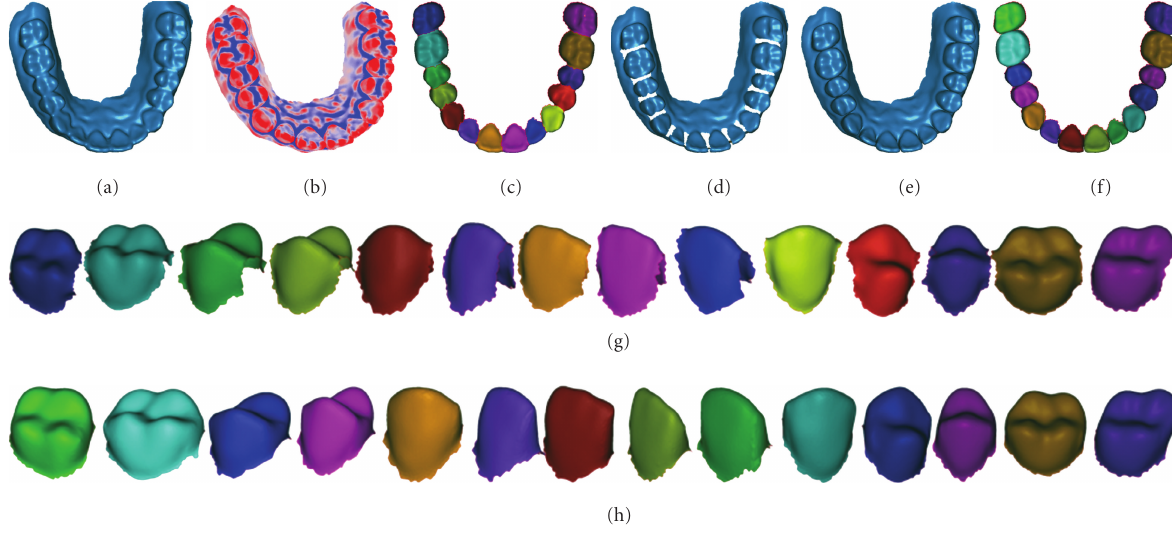
Figure 16: Single-tooth modeling results of 3D dental model with normal tooth arrangement. (a) The initial 3D dental model. (b) Minimum curvature color map. (c) Separation results shown as a whole corresponding to the initial 3D dental model. (d) After the fusion regions being deleted. (e) After single-tooth shape being restored. (f) Separation results corresponding to the 3D dental model after shape restoration. (g) The separated tooth in (c) displayed, respectively. (h) The separated tooth in (f) displayed, respectively.